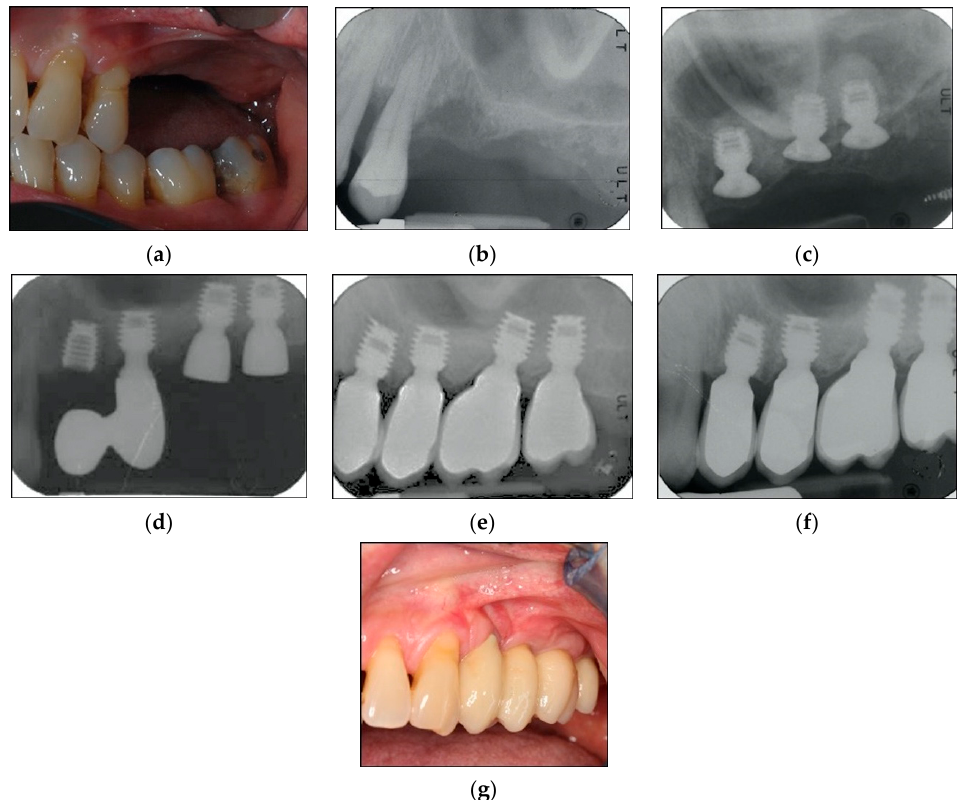
Figure 4 . ( a – g ). Clinical case: Four implants placed in 2.4, 2.5, 2.6, and 2.7 sites. ( a ) Clinical